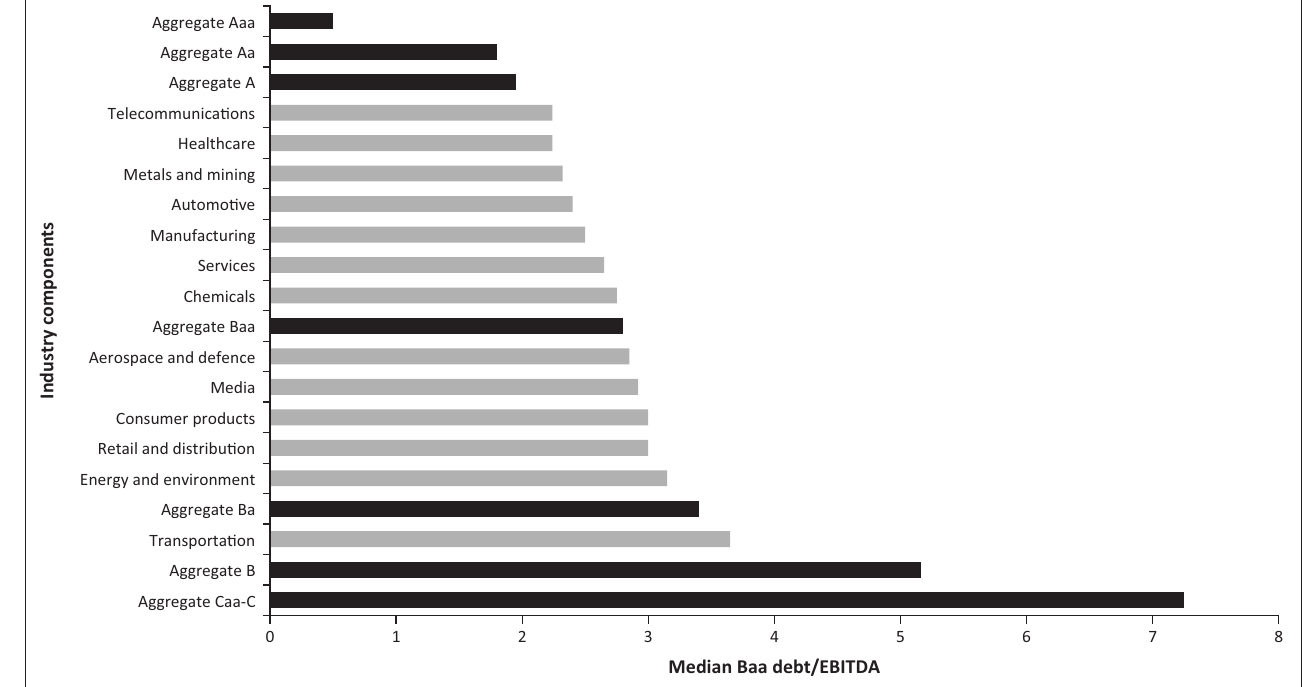
FIGURE 2: Components of Baa-rated institutions